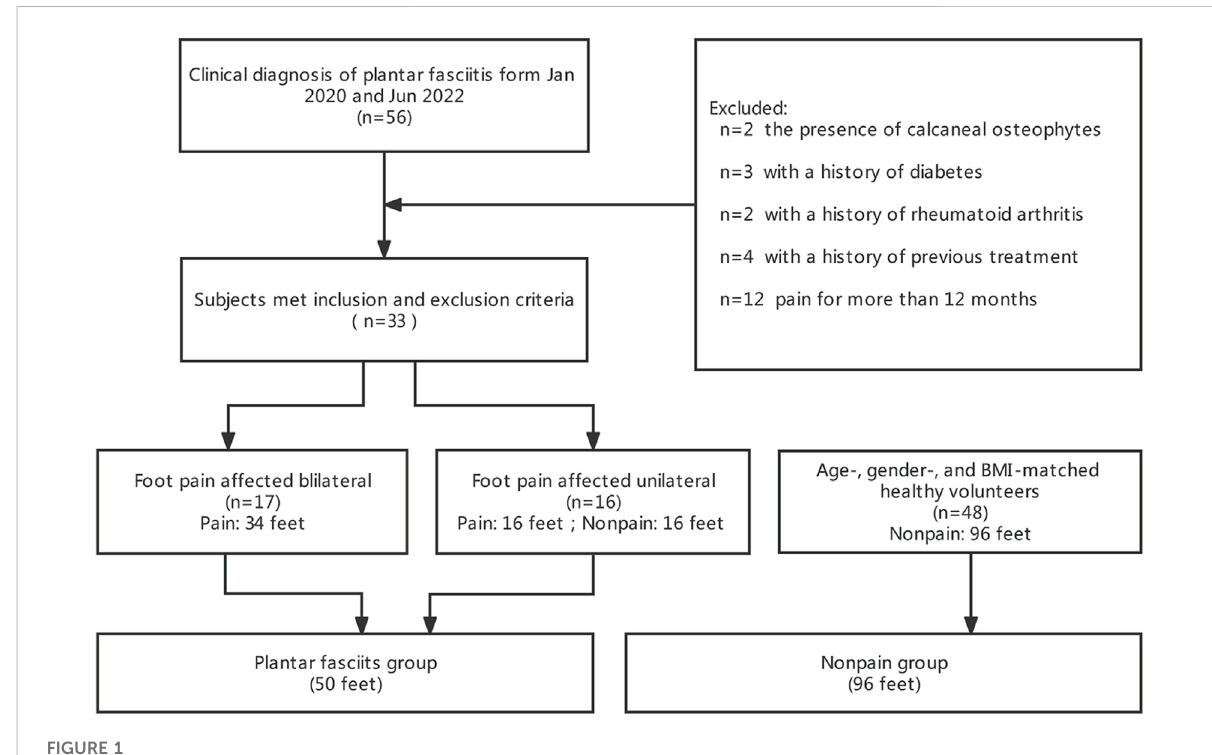
FIGURE 1 Enrollment fl owchart of our